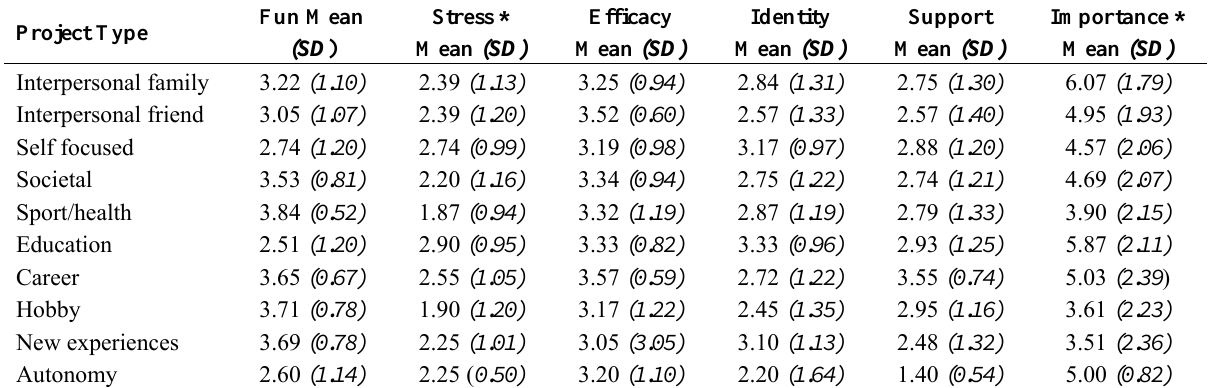
Table 2. Mean scores by project type.